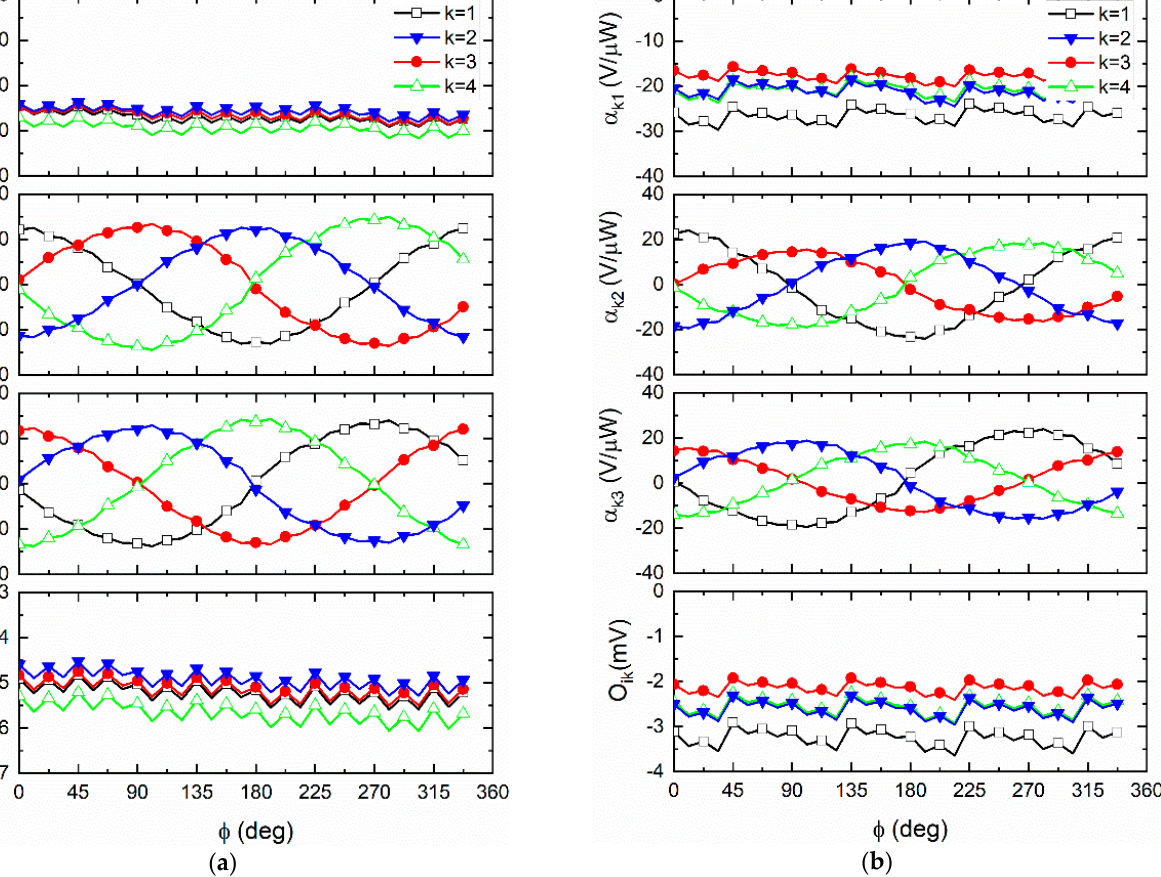
Figure 6. Results of the radiometer calibration, C , o in Equation (12). Sensitivity matrix coefficients, α kj , and offset voltage vector elements, O k , with k the output number, versus phase difference between branches in the BEM φ = φ 2 − φ 1 . ( a ) 10–14 GHz frequency band, ( b ) 16–20 GHz frequency band.